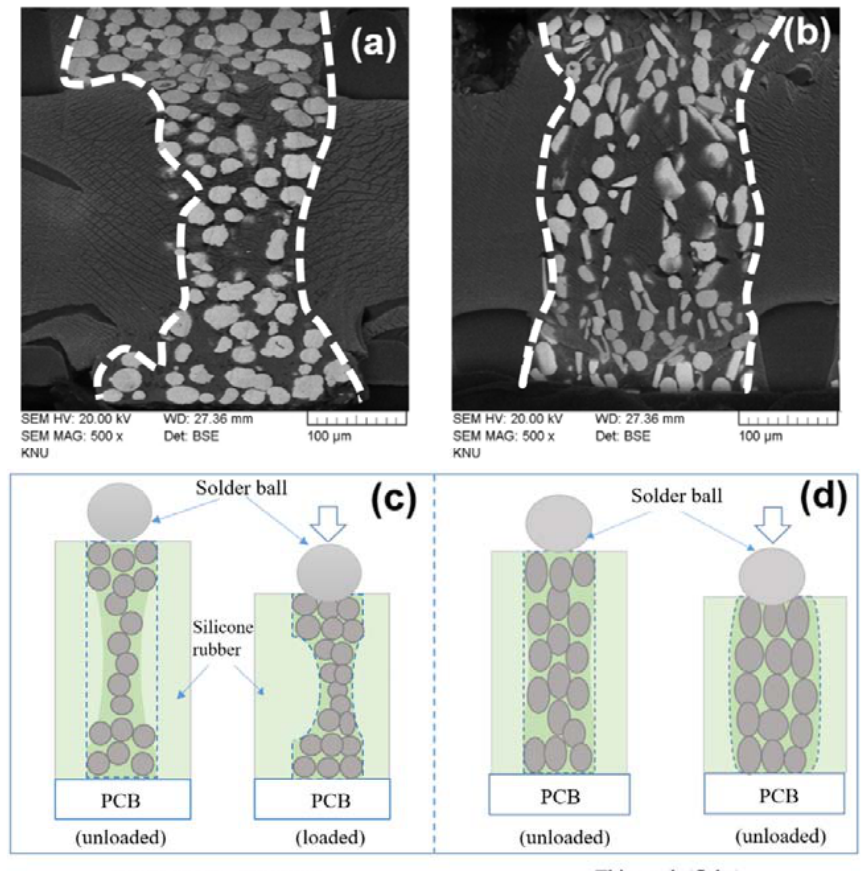
Figure 7. Cross ‐ sectional SEM images of the socket channel shape change according to the compres ‐ sive force of the solder ball. Socket devices with ( a ) spherical Ni powder, ( b ) flake Ni powder, ( c ), and ( d ) are schematic illustrations of the socket device channel deflections.